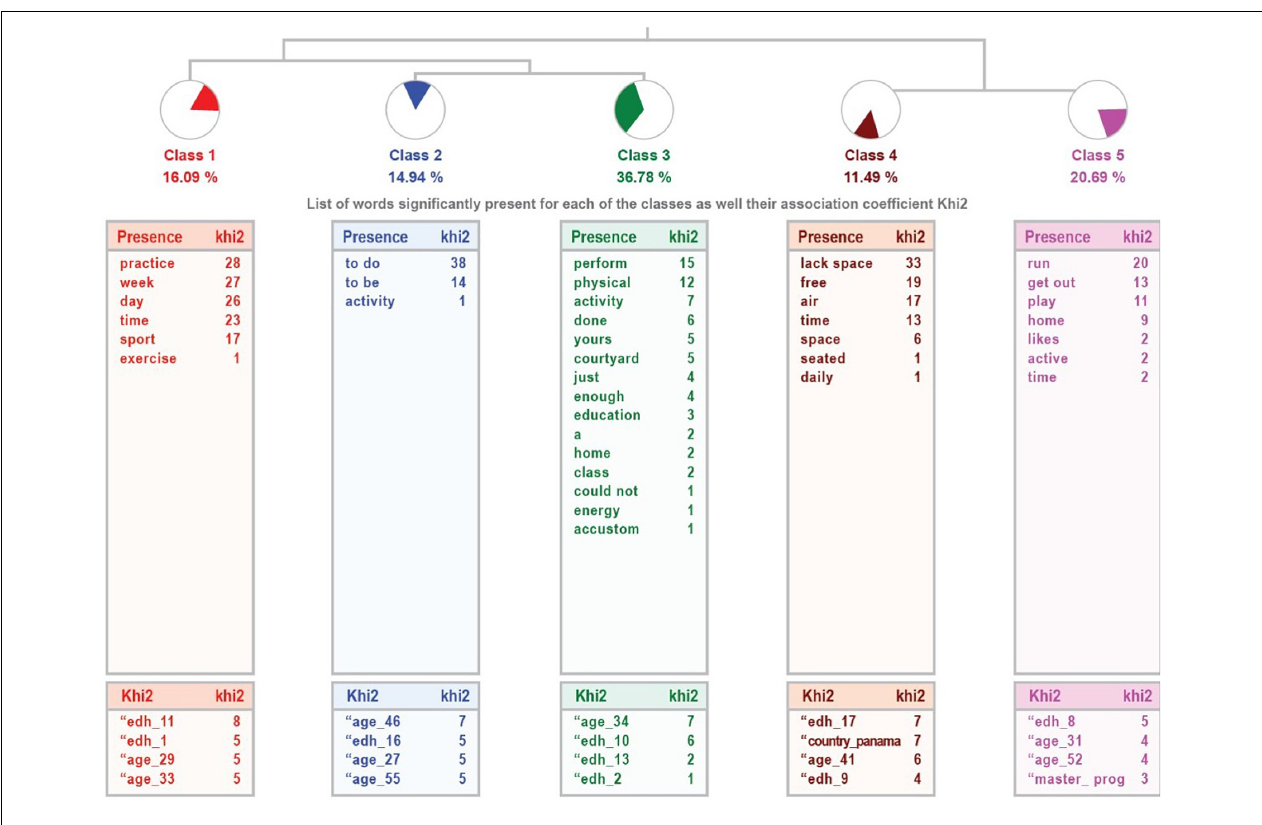
FIGURE 3 | Dendrogram of responses given by parents in the high ability sample. TABLE 12 | Information from the analysis to the question “Is the physical activity developed sufficiently or insufficiently?” High ability sample. Class ECU %